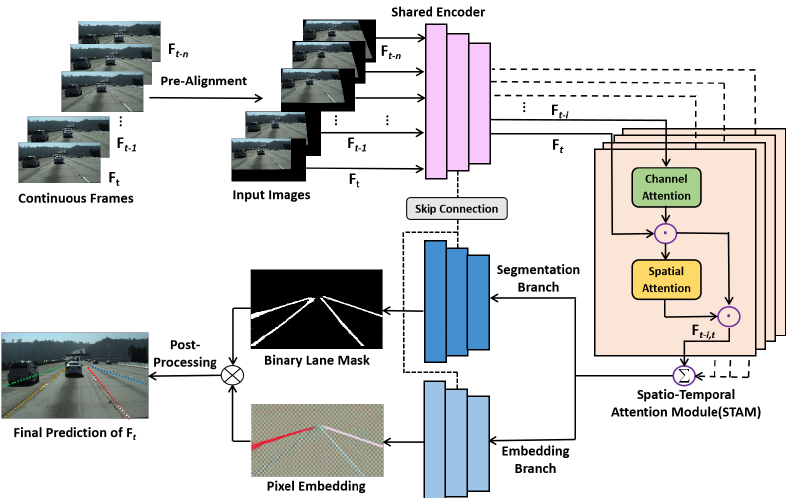
Figure 1. Overview of the proposed method. Multiple pre-aligned consecutive frames are firstly sent to the shared encoder. Then, the features of current key frame F t are enhanced by attentively aggregating spatial-temporal information from history frames F t − i . After that, the two-branch decoder produces a binary lane mask and an N-dimensional embeddings per lane pixel. At last, the post-processing is applied to gain the final predictions.